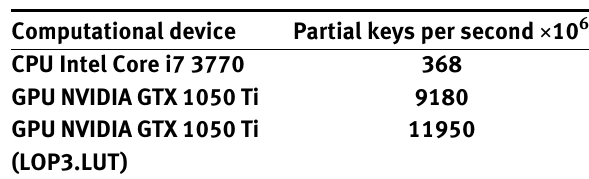
Table 1: Performance of bitslice implementation of Anderson’s at- tack (search space size is 2 53 ) on a CPU and a GPU, measured in millions of partial keys (53 bits out of 64) per